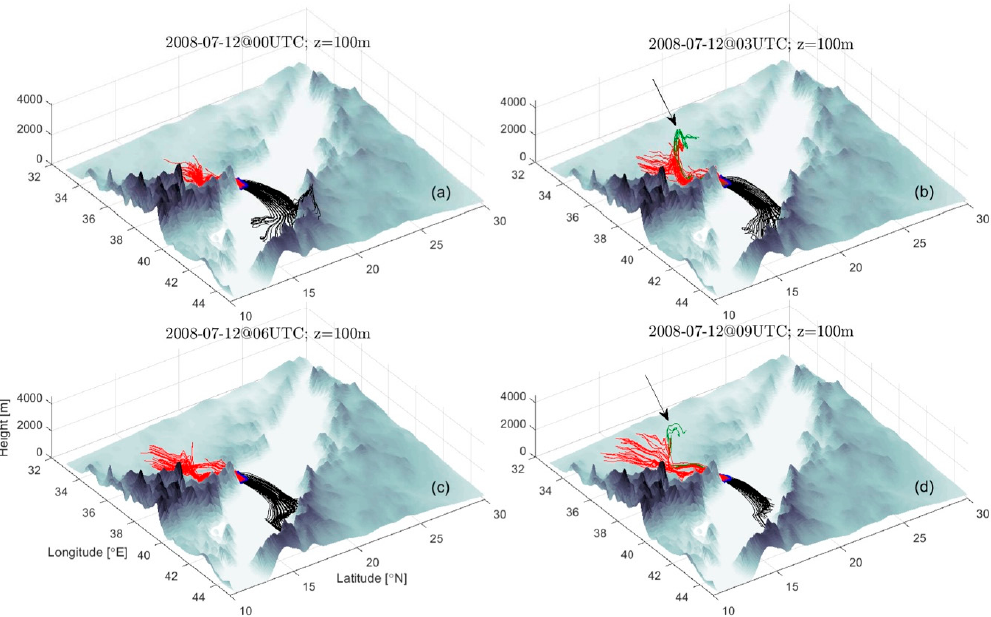
Figure 11. Forward time (black) and backward time (red) trajectories, initiated at the time indicated on each frame and within a horizontal patch (blue area) lying at z = 100 m and where the wind speed exceeds 15 m/s. Trajectories are integrated backward to 12 UTC on 12 July 2008 and forward in time to 24 UTC on 12 July 2008. The arrows point to trajectories that originate from the upstream cell containing strong downdrafts. These trajectories are colored green.